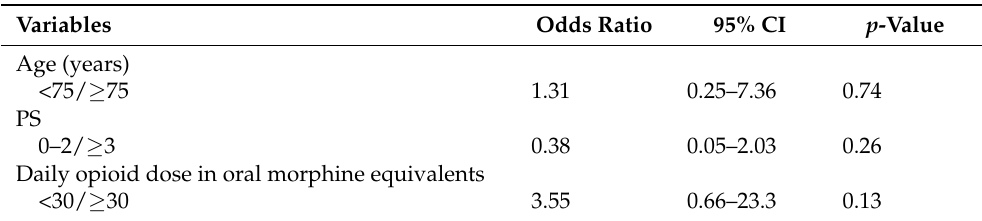
Table 5. Multivariate logistic regression analysis of the clinical factors indicative of response in patients treated with